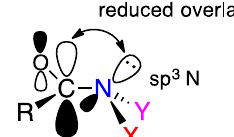
Figure 4. Reduced n